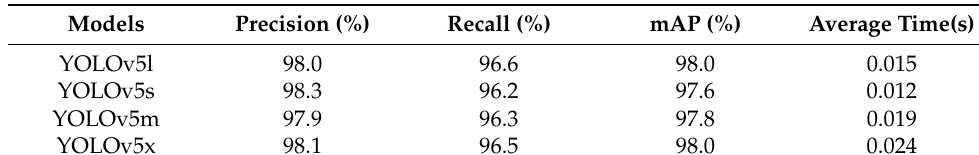
Table 1. Identification results for the pineapple eyes in test set.